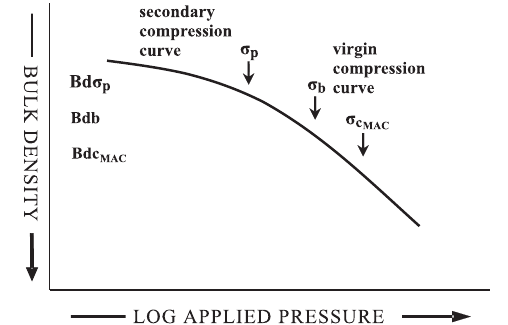
Figure 4. Soil compression curve [variation of bulk density (Bd) as a function of the logarithm of applied pressure ( σσσσσ )] indicating the points corresponding to preconsolidation pressure ( σσσσσ beneficial pressure in terms of water retention ( σσσσσ ) and critical pressure with reduction of b macroporosity to 0.10 dm 3 dm -3 ( σσσσσ corresponding soil densities. Source: Modified from Dias Junior